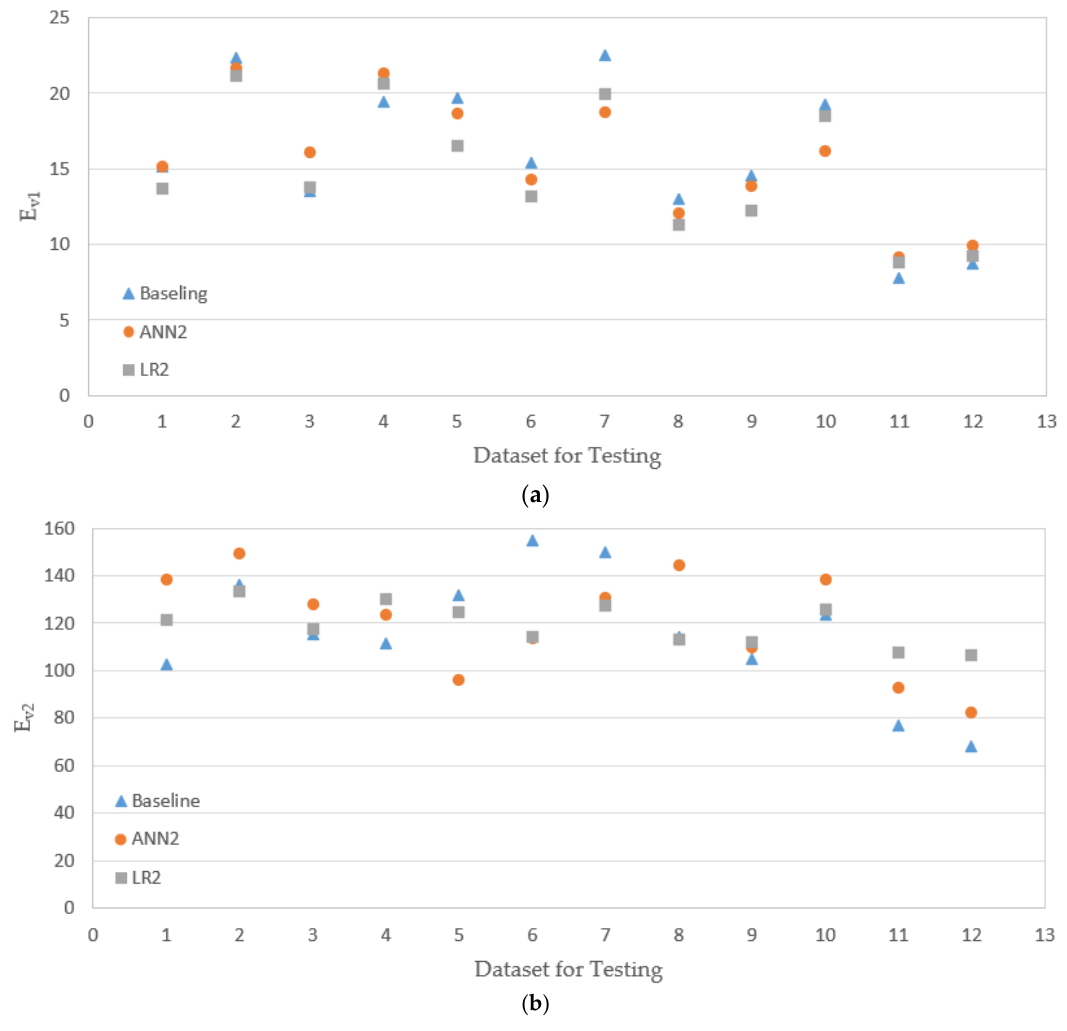
Figure 14. Testing results 2 (results of ANN are based on the model ANN2, and results of LN are based on the model LN2). ( a ) Testing results from E v1 ; ( b ) testing results from E v2 .